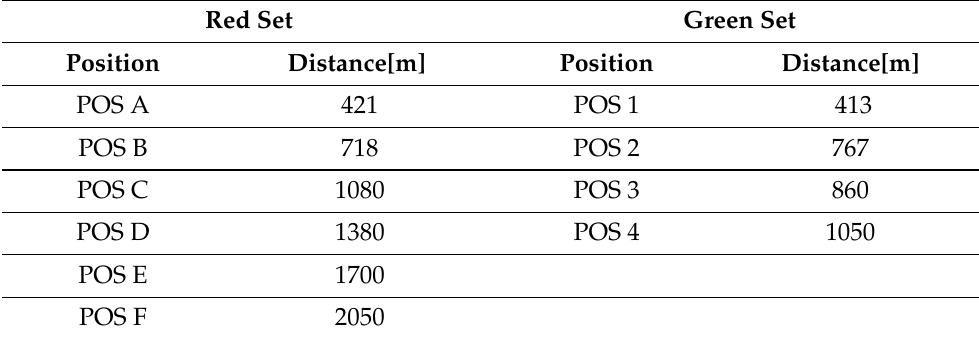
Table 4. Prototype Positions and Distance (approx. straight line) from the gateway